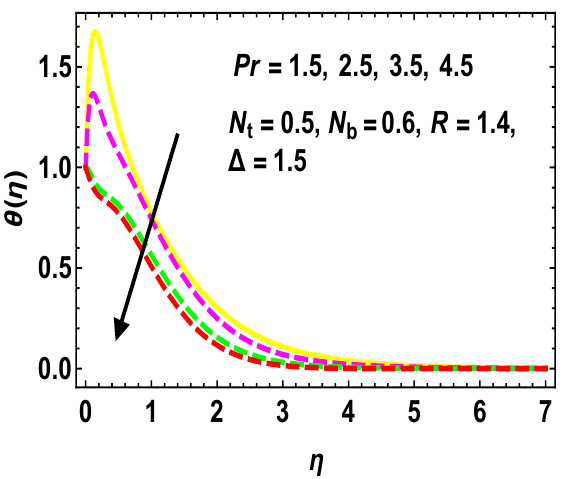
Figure 15. Outcomes of θ ( η ) for R where yellow, magenta, green, and red lines represent for R = 0.1, R = 0.4, R = 0.7, and R = 1.0 respectively.